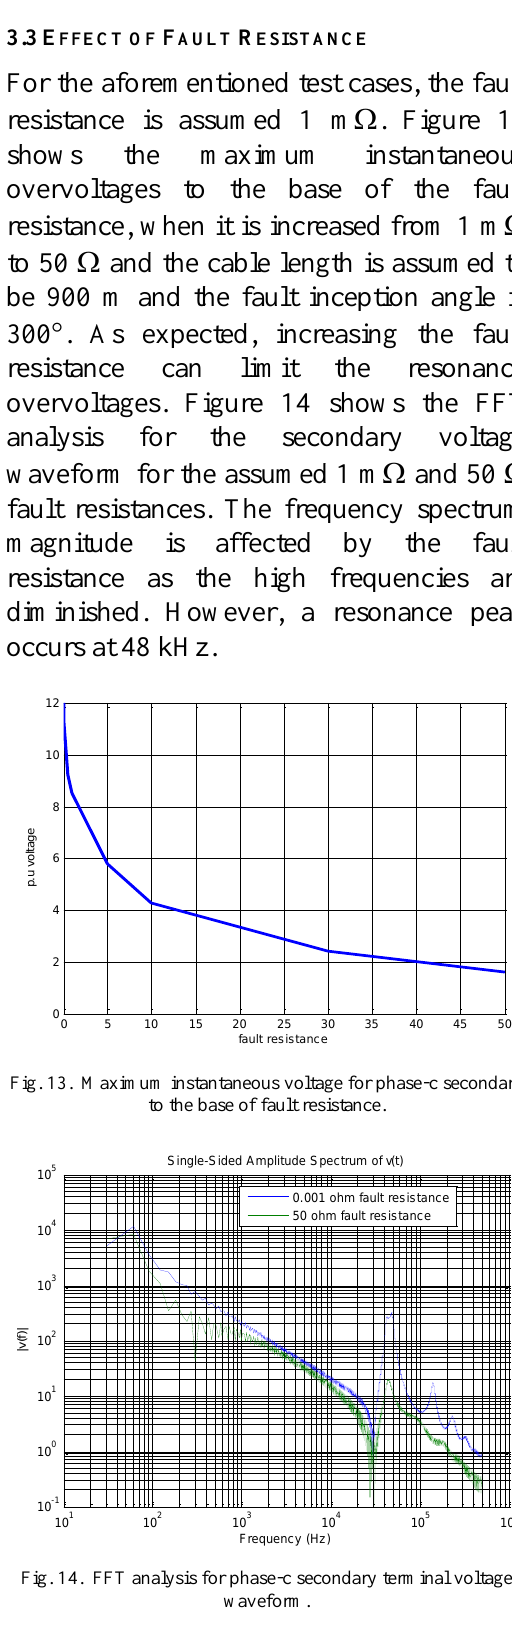
Fig. 15. The transformer primary side terminal